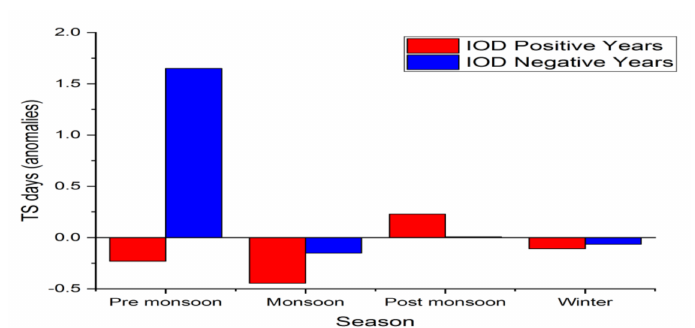
Figure 12. Same as Figure 10, but for IOD.